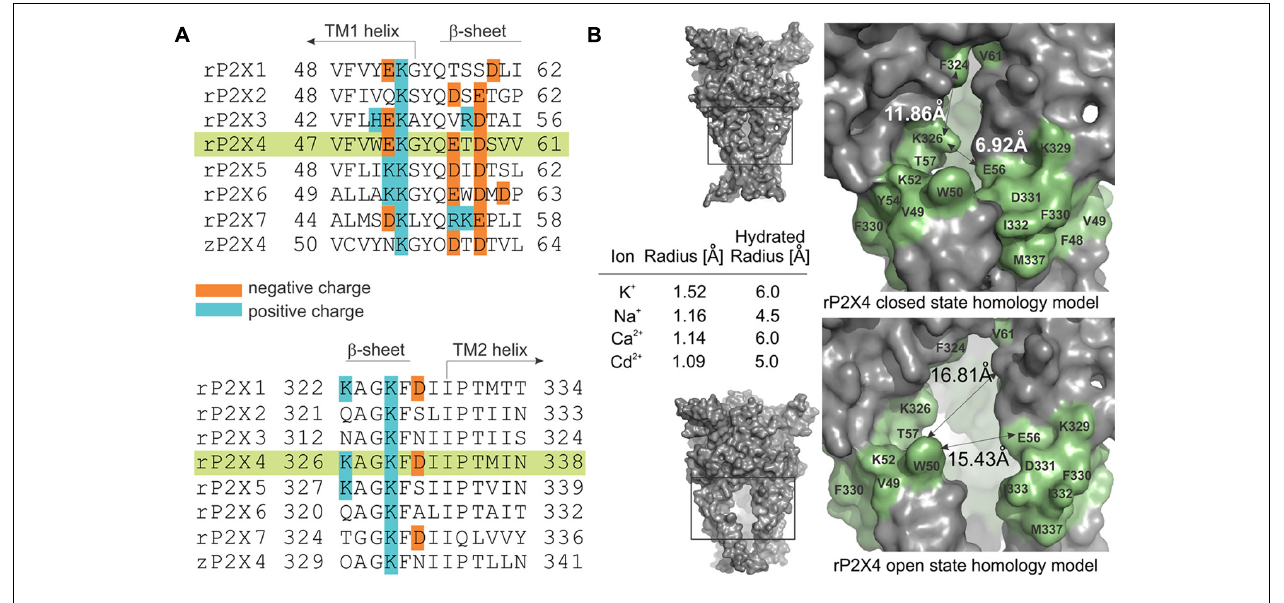
FIGURE 1 | Characteristics of the ion access point of P2XRs. (A) Multiple sequence alignment of seven rat P2XRs compared to zP2X4.1R.The sequence alignments contain the amino acid residues that are homologous to theV47–V61 and K326–N338 segments of rP2X4R (green shade), and the positively and negatively charged residues are indicated. (B) The surface landscape of the homology model for rP2X4R in a closed and open state; the